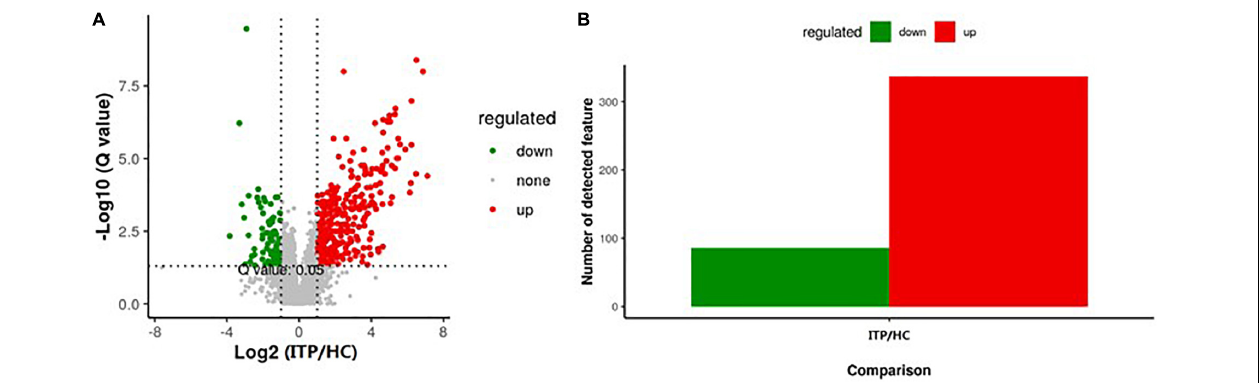
FIGURE 3 | Alterations of metabolites of gut microbiota in ITP patients. (A) The vertical lines corresponded to a 2.0-fold change (up and down). The horizontal line represented a P -value of less than 0.05. The red and green dots represented upregulation and downregulation of microbiota, respectively. (B) Overall, 337 metabolites were significantly upregulated, while 86 were significantly downregulated.